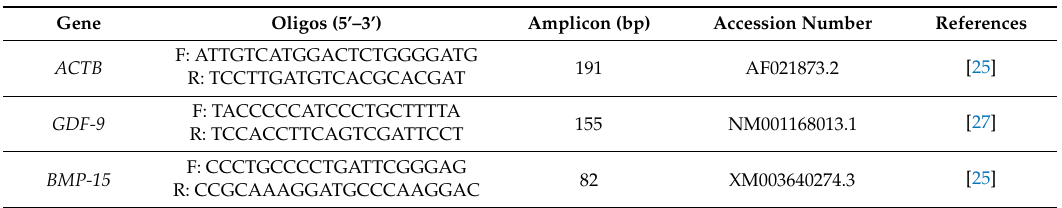
Table 1. Sequences of GDF-9 and BMP-15-specific primers and reference gene used in this study for qRT-PCR